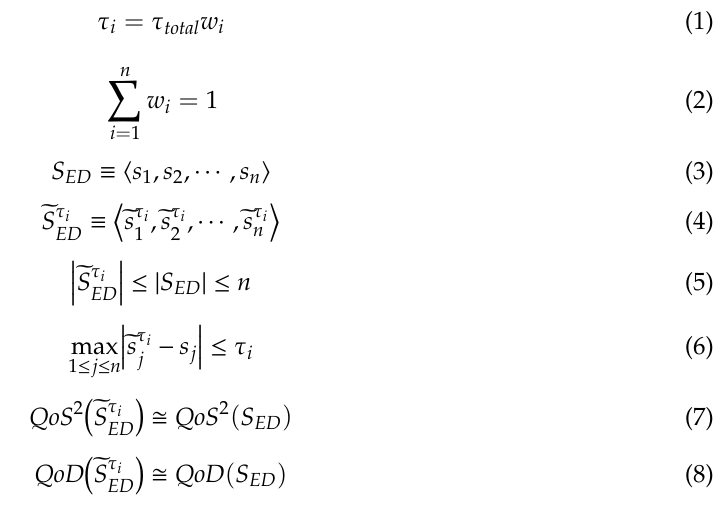
Figure 3. Proportionally divided BEA.   = τ